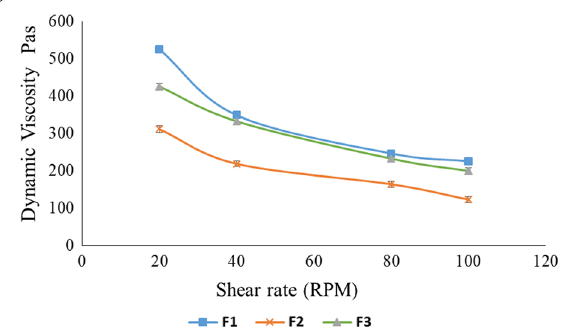
Fig. 4 Graph of dynamic viscosity plotted against shear rate of formulations F1–F3. (All data sets ( p <